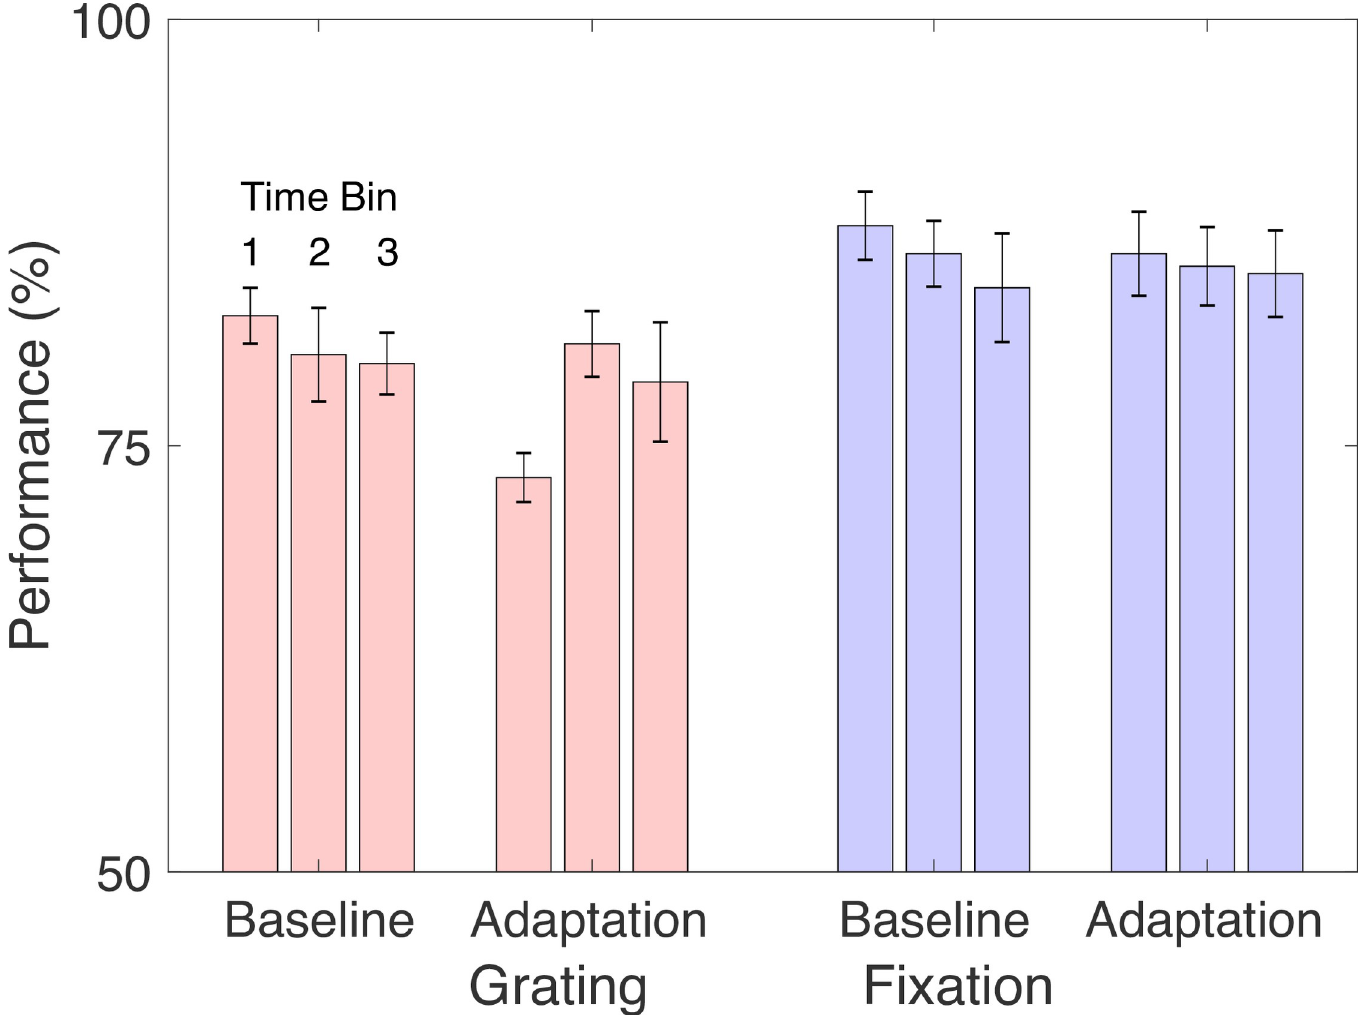
Fig 9. Performance on secondary tasks. Mean performance on the Grating Task and the Fixation Task in Exp. 2 is shown. Plotting conventions are as in Fig 6.